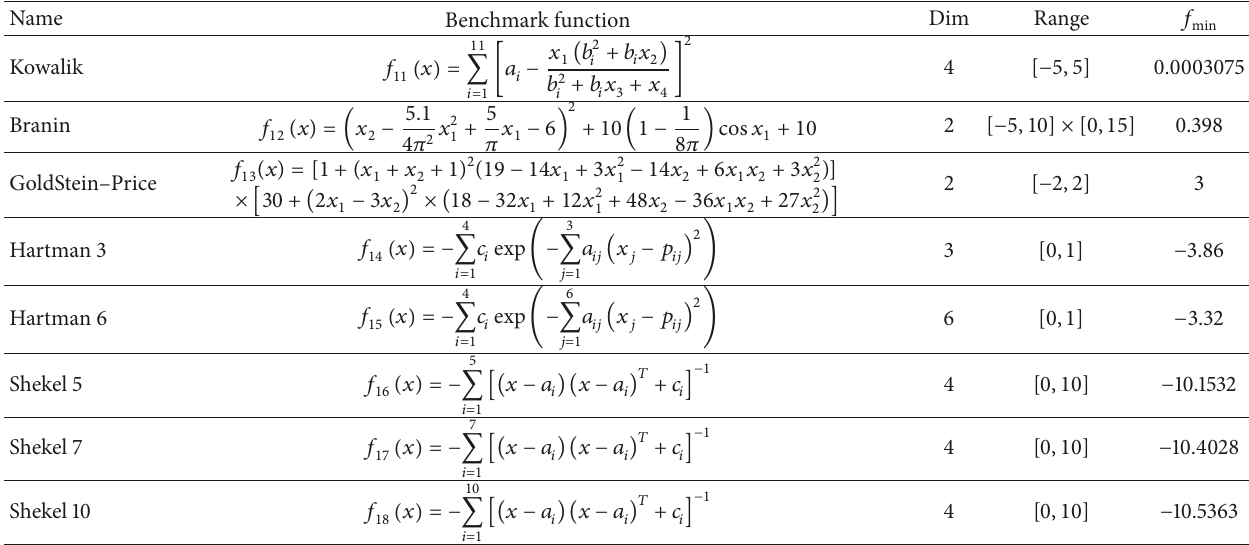
Table 3: Fixed-dimension multimodal benchmark